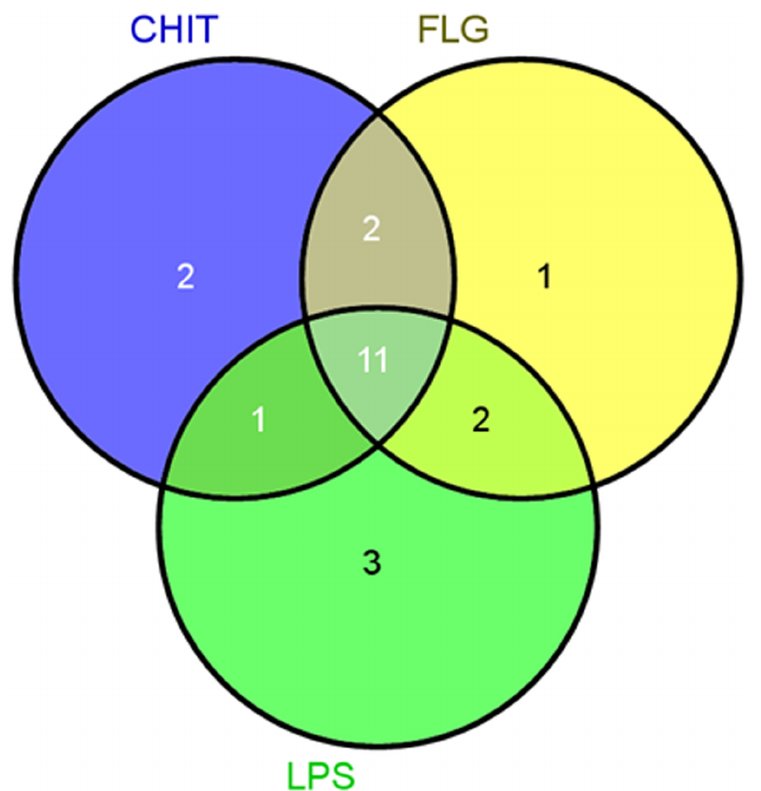
Fig 7. Venn diagram of metabolites positively correlated to the lipopolysaccharide (LPS), chitosan (CHT) and flagellin peptide-22 (FLG) treatment of tobacco cells. The diagram shows overlapping and distinct metabolites indicated by the numbers in the intersections and circles respectively. The specific metabolites are indicated in Table 1.